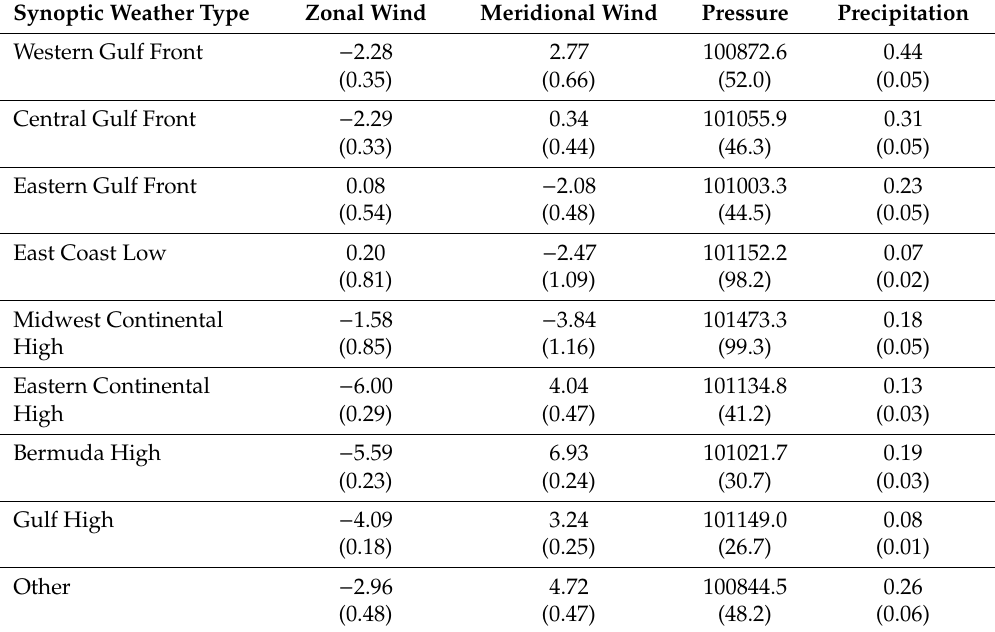
Table A2. Mean (and standard error) measurements of zonal wind (blowing east or west) and meridional wind (blowing north or south) speed (m / s) at 925 mb, air pressure (Pa) at surface, and accumulated total precipitation (kg / m 2 ) at surface from North American Regional Reanalysis points over the Gulf of Mexico associated with each synoptic weather type. The zonal wind component estimates wind speed in the east–west direction (positive if blowing towards the east and negative if blowing towards the west), and the meridional wind component estimates wind speed in the north–south direction (positive if blowing towards the north and negative if blowing towards the south). All measurements were taken at 6:00 UTC the night prior to migrants departing stopover sites. The first five synoptic weather types were considered unfavorable (Western Gulf Front, Central Gulf Front, Eastern Gulf Front, East Coast Low, and Midwest Continental High) and the following three favorable (Eastern Continental High, Bermuda High, and Gulf High). The last synoptic weather type consisted of a subset of instances that did not fit into one of the eight prior